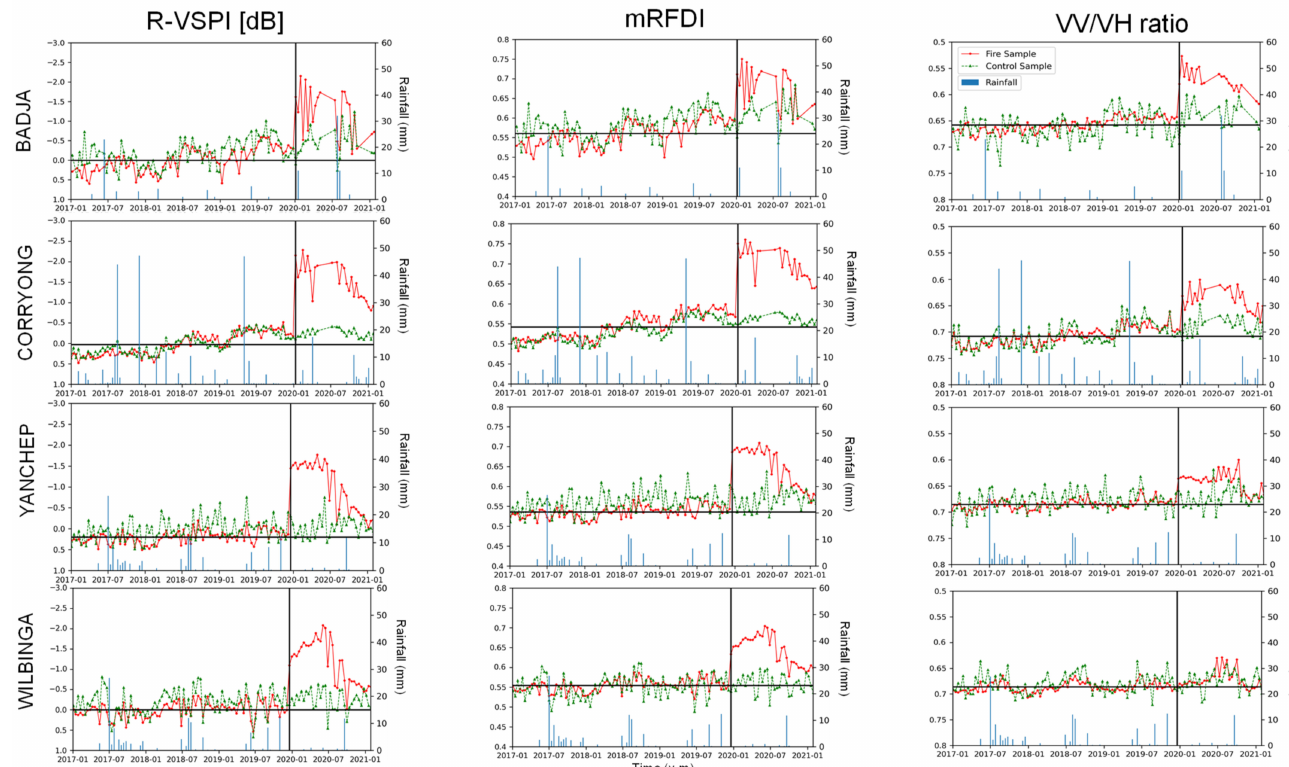
Figure 6. Four-year time series of R-VSPI, mRFDI, and VV/VH ratio using Sentinel-1 backscatter dataset for the other four selected wildfires. Data are shown for burnt/wildfire samples (red) and control samples (green). The black lines indicate the latest imagery post the wildfire event (vertical) and pre-fire conditions (horizontal, mean of the wildfire sample taken pre-fire). The rainfall data is shown in column bars